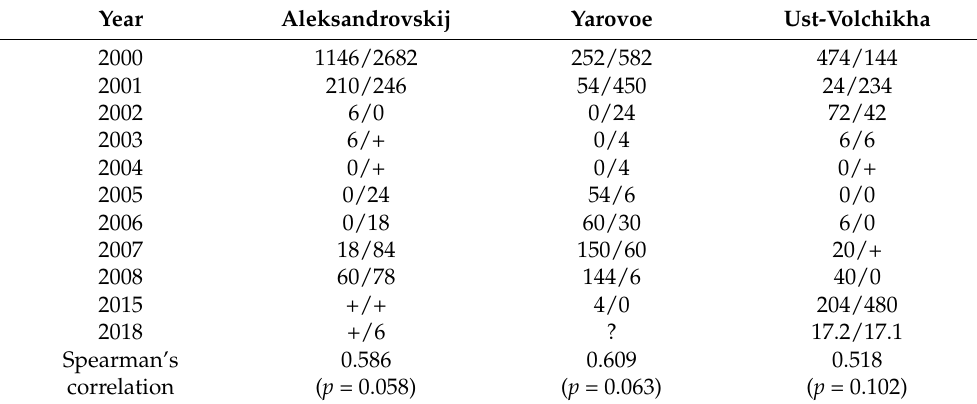
Table 2. Dynamics of the abundance (ind. per hour) of Oedaleus decorus relative to the abundance of the Italian locust in the Kulunda